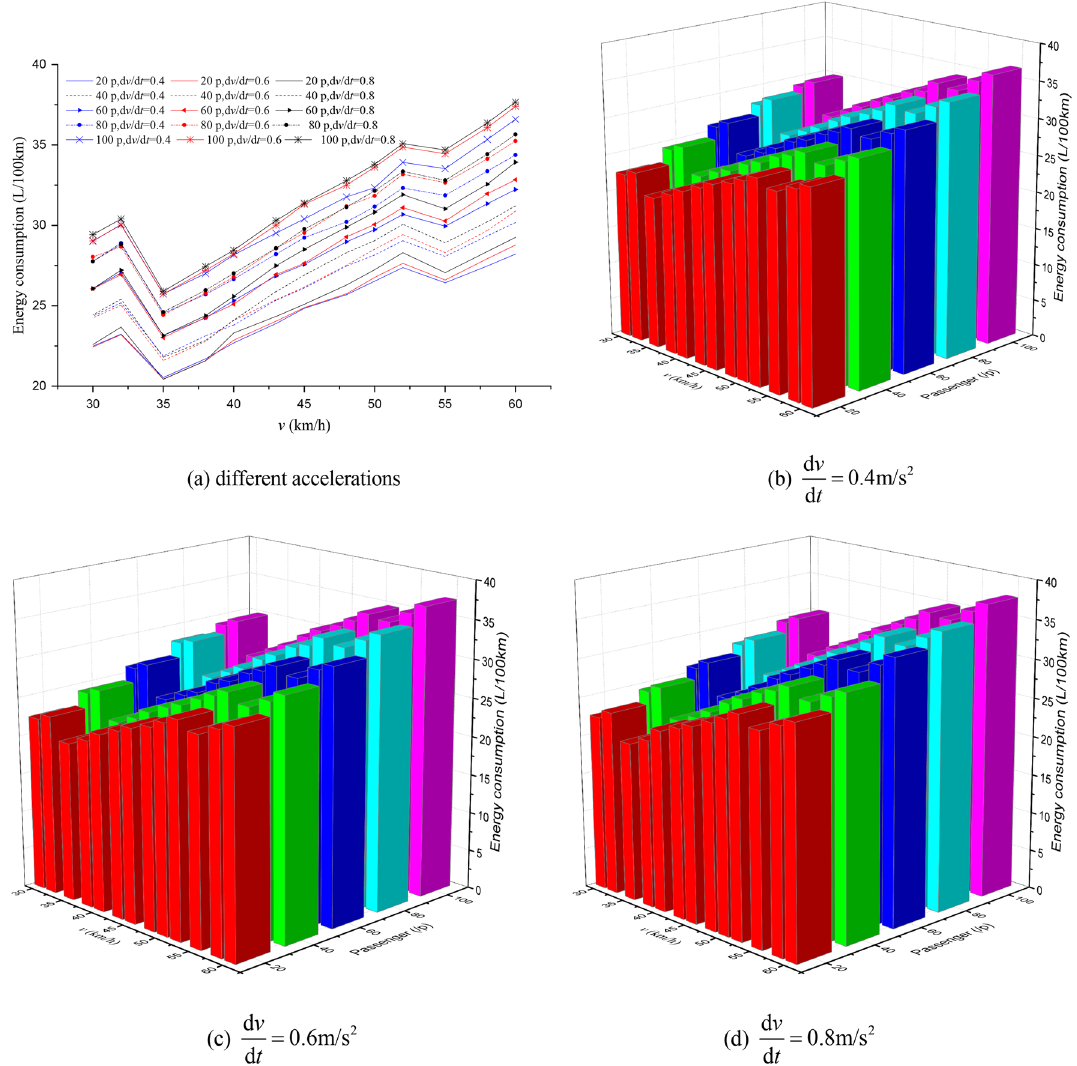
Figure 11. The EC of different passenger load, acceleration and maximum speed for 1200 m station